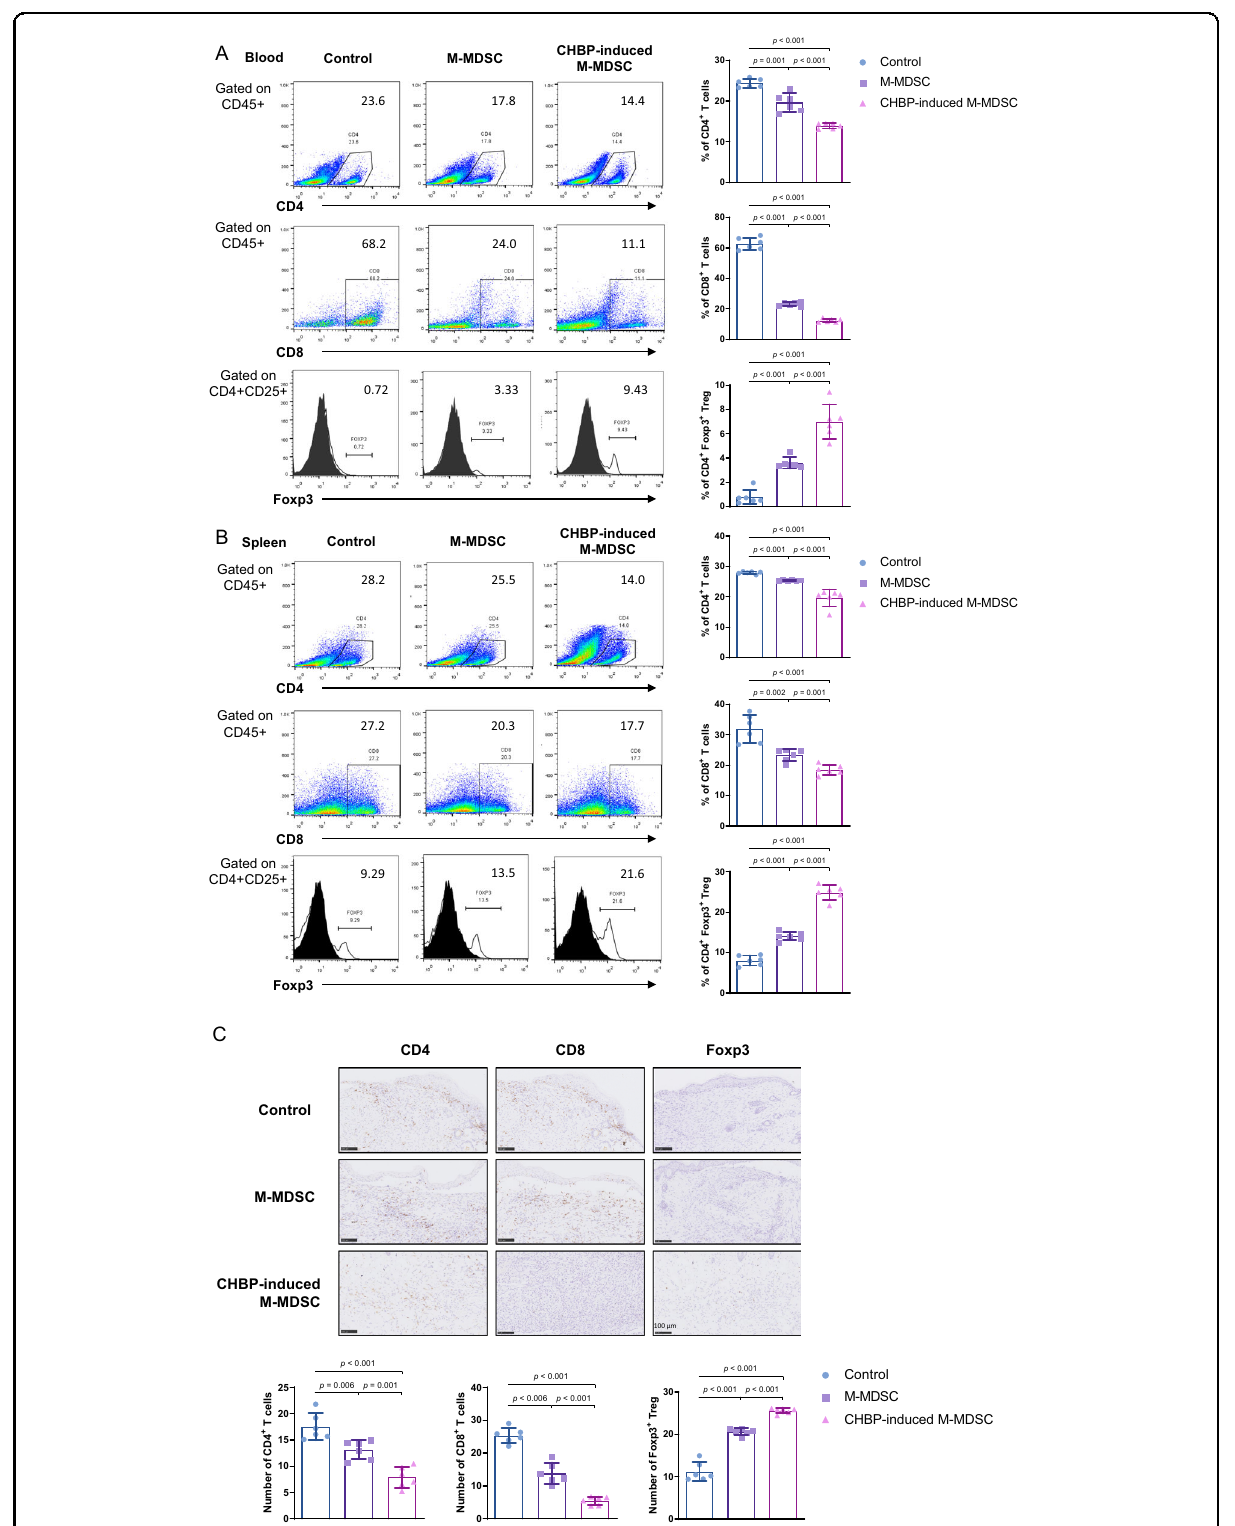
Fig. 3 Infusion of CHBP-induced M-MDSCs decreased CD4 + , CD8 + T cells, and increased Tregs in peripheral and skin. A Detection of the proportion of CD4 + , CD8 + T cells, and Foxp3 + Tregs in the blood. B Detection the proportion of CD4 + , CD8 + T cells, and Foxp3 + Tregs in the spleen. C CD4, CD8, and Foxp3 immunohistochemistry staining in the alloskin with semi-quanti fi cation analysis (POD 14). Scale bar: 100 μ